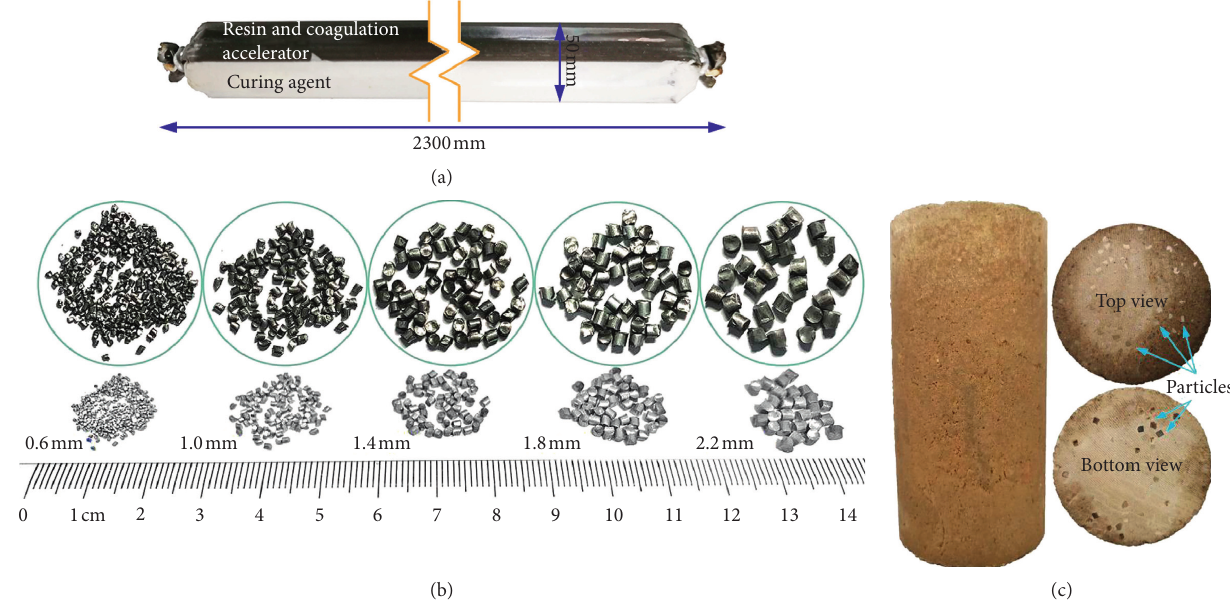
Figure 1: Exhibition for resin capsule, steel particles, and prepared specimen. (a) Resin capsule, (b) steel particles (note that the circled enlarged views are not scaled), and (c) a prepared specimen containing 120g of 1.8mm steel